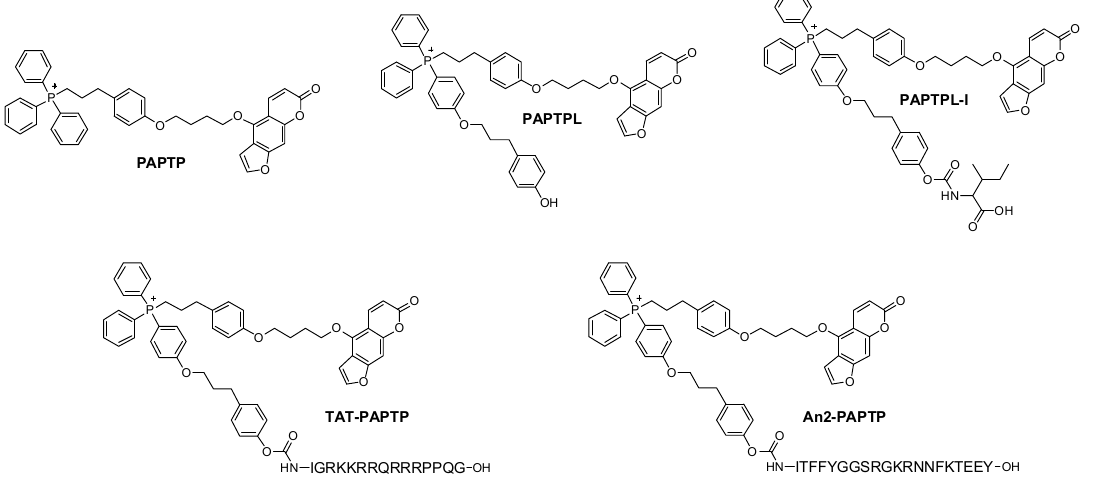
Figure 1. Structure of the major compounds synthesized.